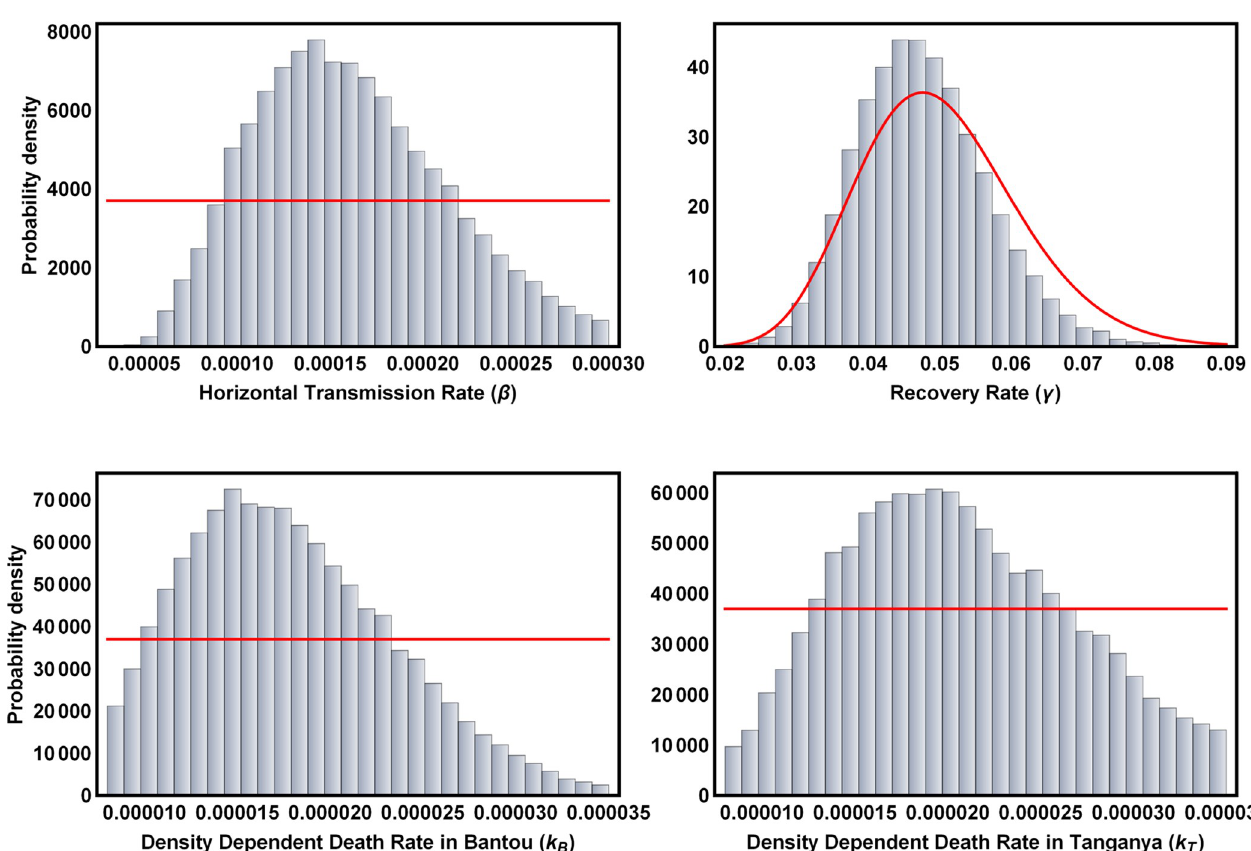
Fig 3. Posterior distributions for key model parameters estimated by our ABC method when applied to time series data from the villages of Bantou and Tanganya. The red lines show the prior distribution for each parameter and the bars the posterior probability density.